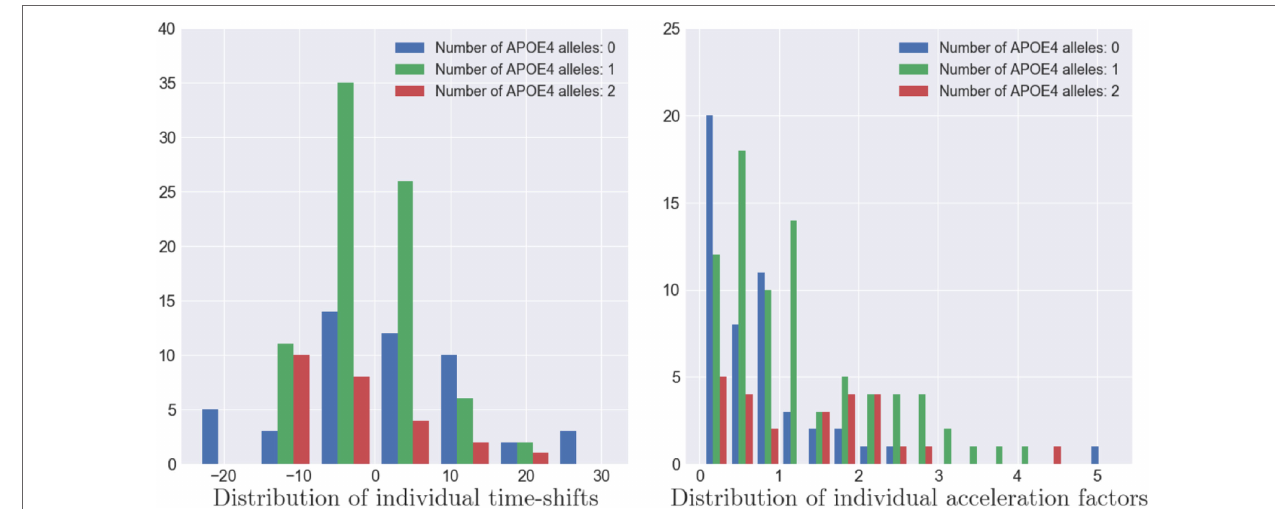
FIGURE 11 | Distribution of the individual time-shifts (left) and the individual acceleration factors (right) for three types of APOE- ϵ 4 population. A larger number of alleles of the APOE- ϵ 4 genes is correlated to a faster pace of propagation of the Alzheimer’s disease ( p -value ≃ 0.001) but not with an earlier atrophy onset ( p -value ≃